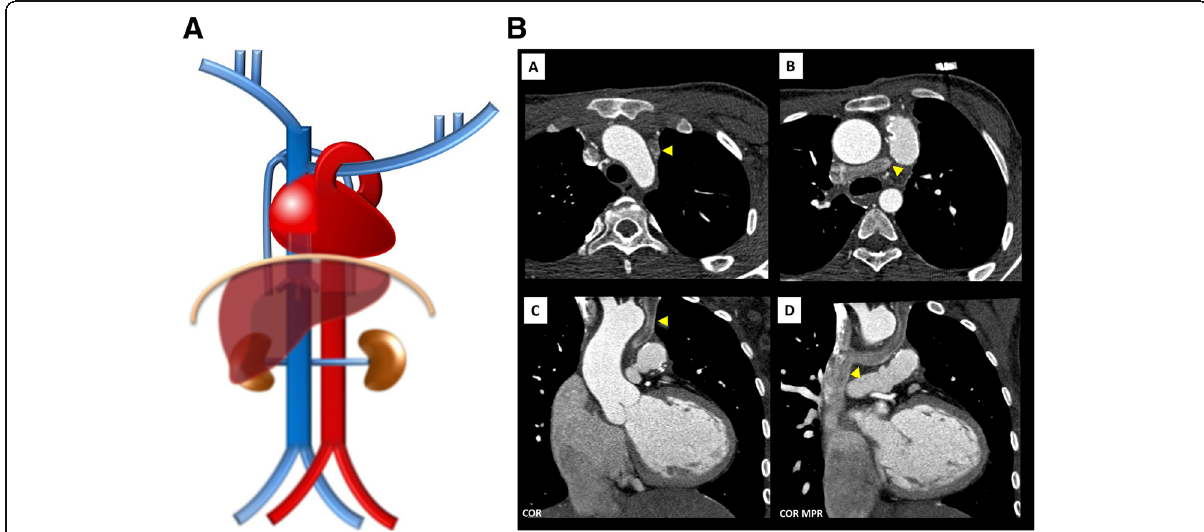
Fig. 5 a Anomalous course of the left brachiocephalic vein schematic. Anomalous course of the left brachiocephalic vein, crossing dorsal to the ascending aorta, beneath the aortic arch, ending on the SVC caudal to the azygos vein. b Anomalous course of the left brachiocephalic vein imaging. Contrast-enhanced CT [A, B — axial plane, C, D — coronal plane] showing an anomalous course of the left brachiocephalic vein (triangle) draining into the SVC dorsal to the ascending aorta with a course in the aortopulmonary